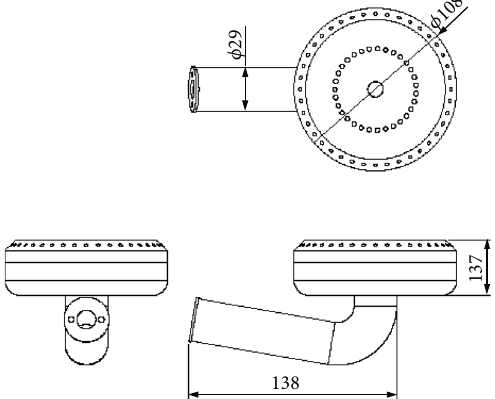
Figure 1: 3D geometry of a